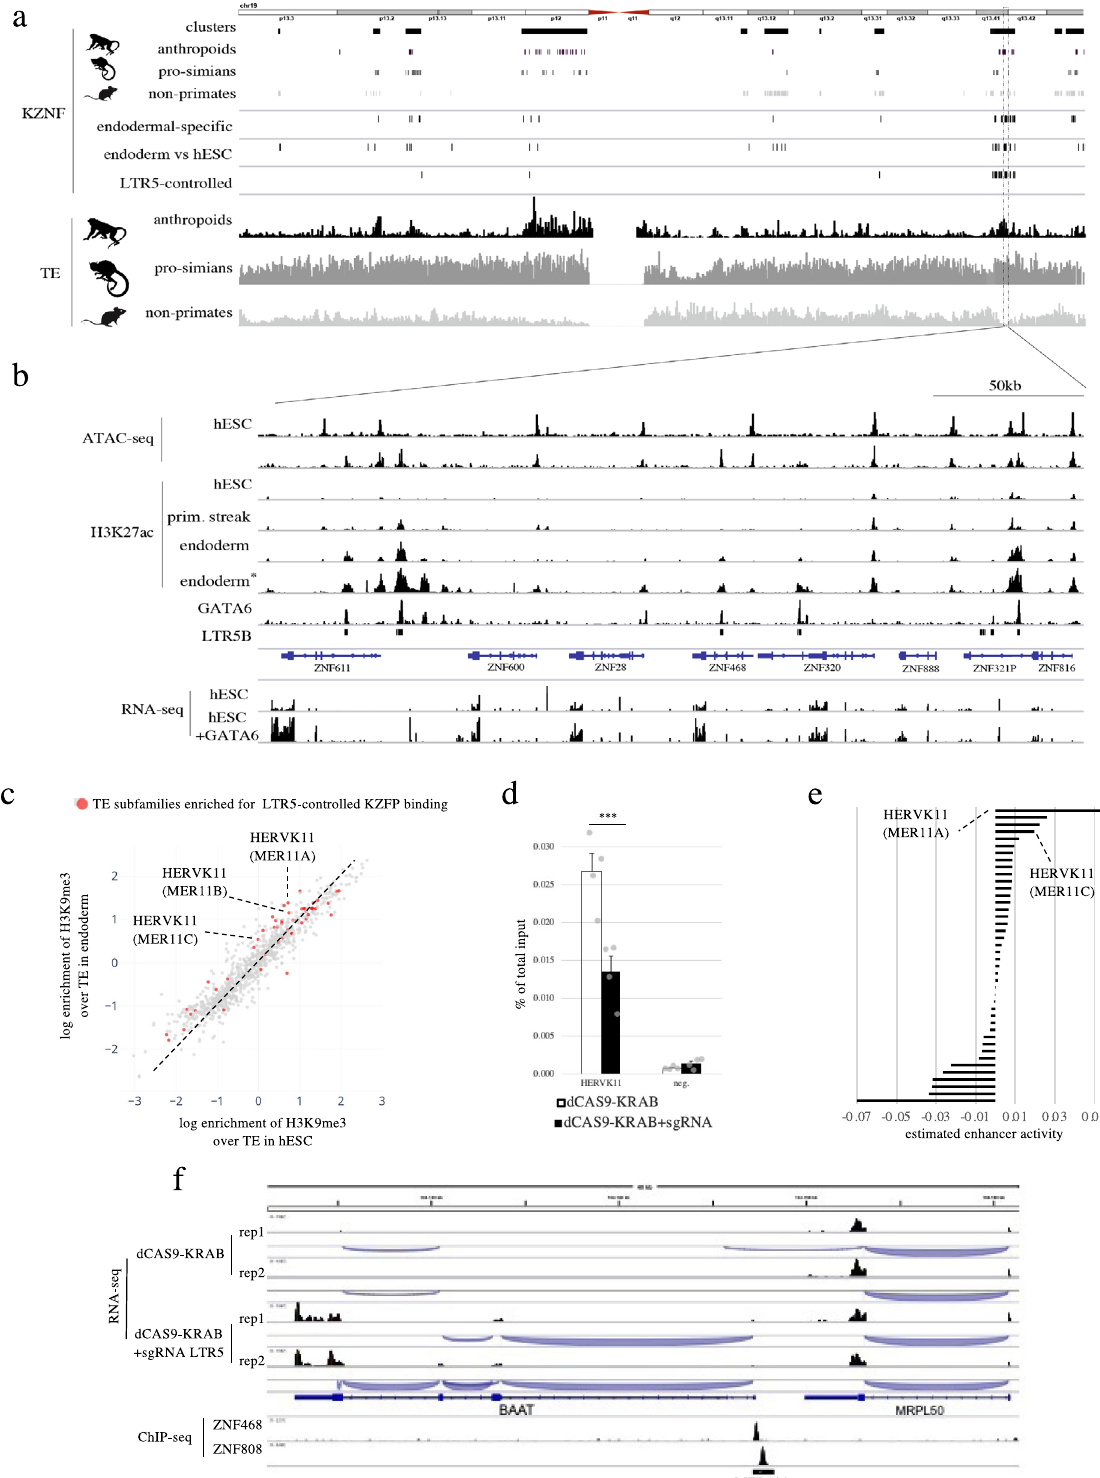
(Fig. 2c, Fig. S2b – e). Cellular clustering matched increased